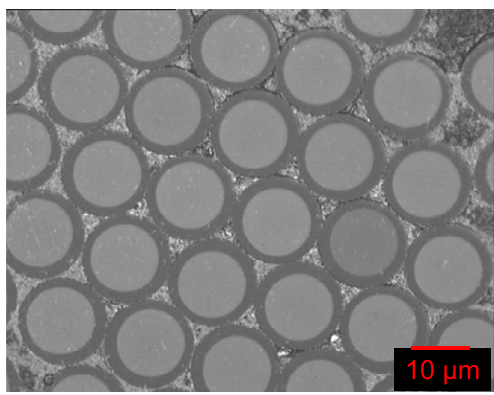
Figure 1. Micrograph of the custom-made small-diameter optical fibres showing the core and the cladding.